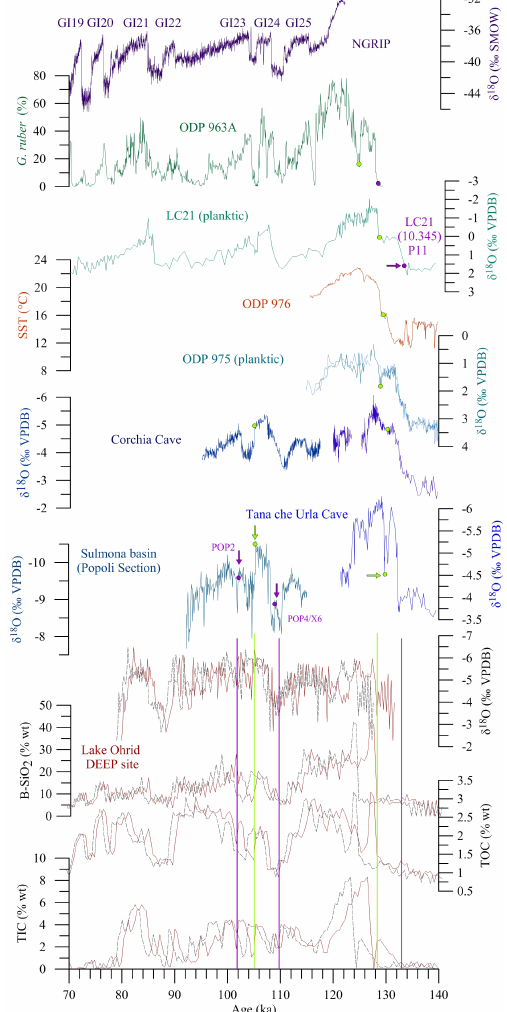
Figure 3. Comparison of selected DEEP proxies (TIC δ 18 O after Lacey et al. (2016), B-SiO 2 after Francke et al. (2016), TOC and TIC % after Francke et al., 2016) with regional to extra regional record. From the bottom: δ 18 O from Sulmona paleolake (POP sec- tion, Regattieri et al., 2015); δ 18 O from Corchia Cave (CC5 Drys- dale et al., 2009; CC28 Drysdale et al., 2007) and Tana che Urla Cave (Regattieri et al., 2014); ODP-975 planktic δ 18 O ( G. ruber darker; G. bulloides , lighter, after Marino et al., 2015); ODP-976 Alkenone SST (data from Martrat et al., 2014 and age model af- ter Marino et al., 2015); LC21 planktic δ 18 O ( G. bulloides Grant et al., 2012); ODP-963A G. ruber abundance (Sprovieri et al., 2006); δ 18 O from NGRIP ice core (NGRIP member, 2004). Vio- let dots indicates correlated tephra layers (LC21 10.345/P11 on core LC21 and ODP-963A, POP2 and POP4/X6 on Sulmona Basin δ 18 O record, Regattieri et al., 2015); green dots indicate correlated points used for tuning. Arrows and lines (violet = tephras, green = tuning point) indicate age tuning points. See text and Table 1 for details. Dotted lines are the same proxies, but plotted using the Franke et al. (2015) age